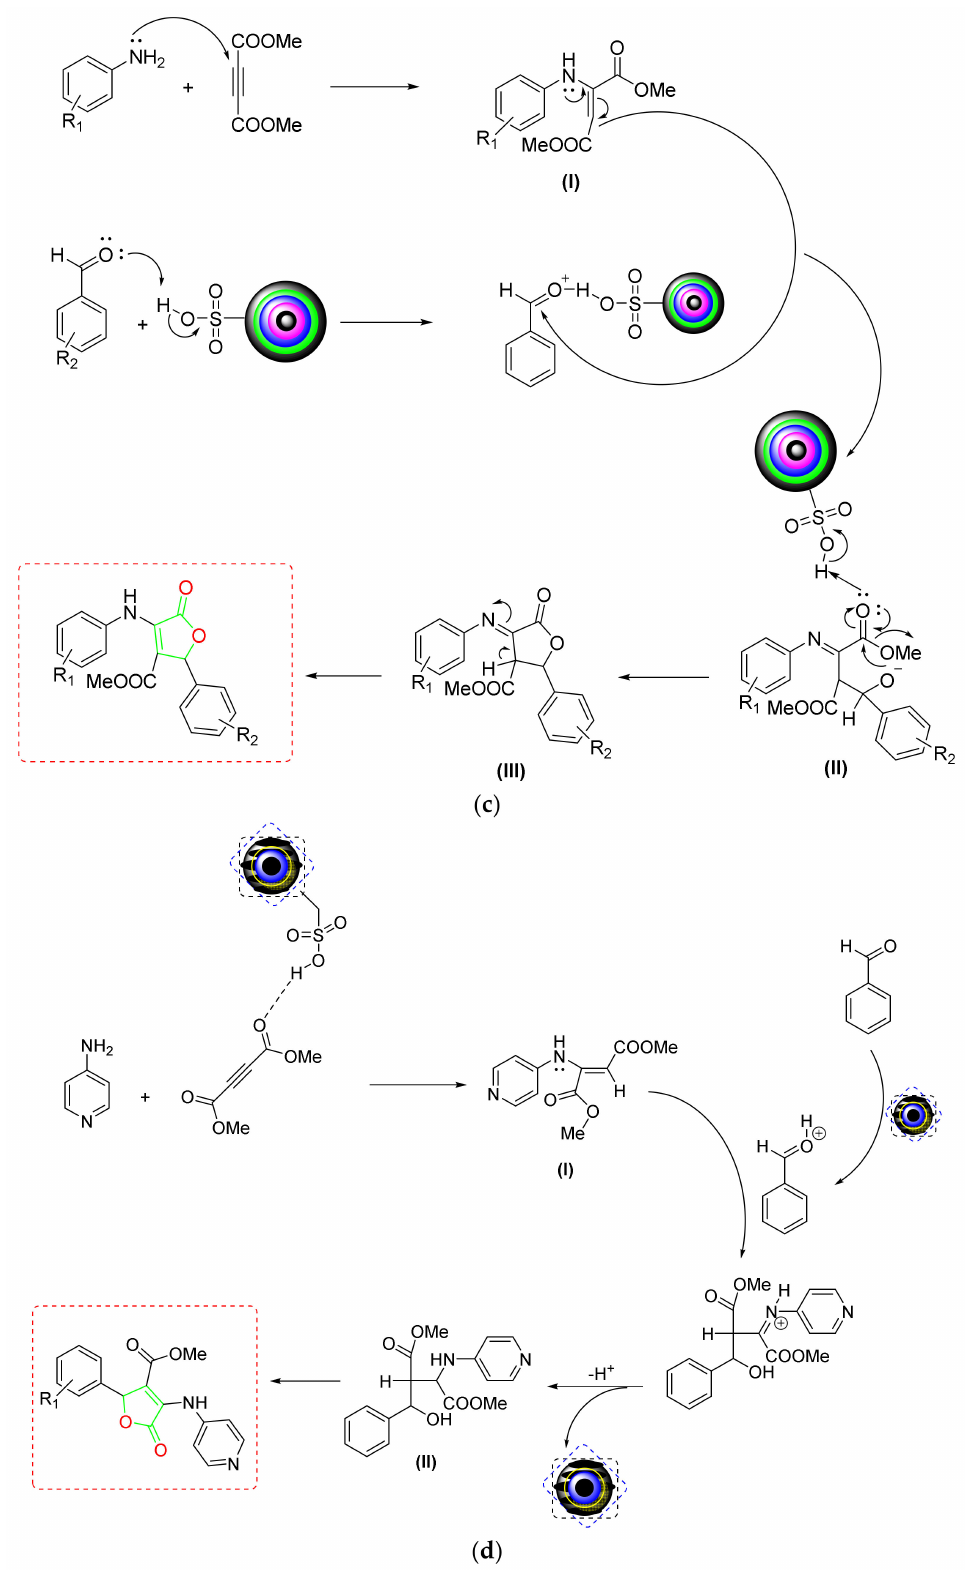
Scheme 5. The schematic representation to design furan derivatives by utilizing different NCs ( a ); Suggested mechanism to synthesize furan-2(5H)-ones by using SA-ABTCA-Fe 3 O 4 ( b ); Reported mechanistic pathway for the nanocatalyzed synthesis of furan derivatives ( c ); Proposed mechanism to achieve 3,4,5-trisubstituted furan-2(5H)-ones by using organic-inorganic hybrids NC ( d